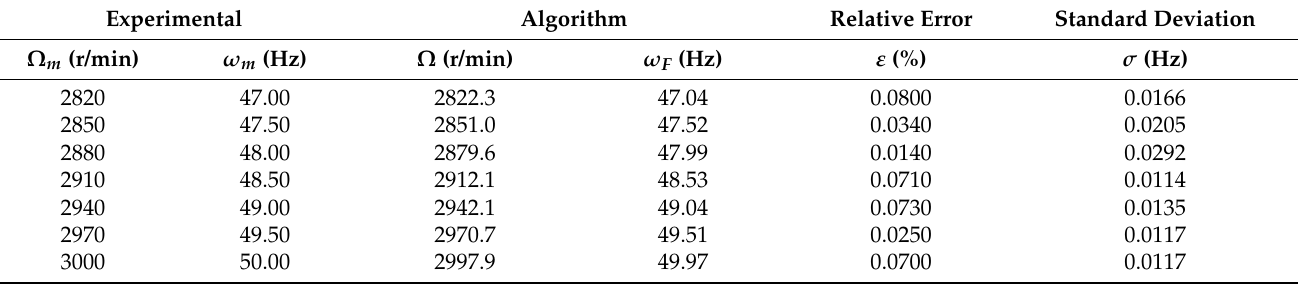
Table 4. No load coupled to the motor shaft: estimated speeds and frequencies, relative errors, and standard deviations. Experimental Algorithm Relative Error Standard